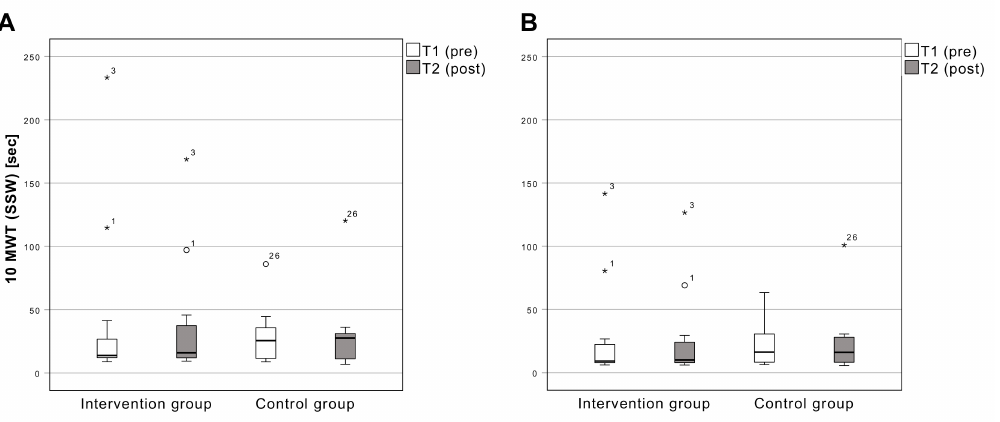
Figure 3. Results of the 10 m walking test with SSW ( A ) and maximum walking speed ( B ). Boxplots: Middle line: median; lower whisker: minimum value; upper whisker: maximum value; circles: Outliers (1.5 times interquartile range); *: extreme outliers (3.0 times interquartile range; numbers: Case numbers); p < 0.05; SSW: Self-Selected Walking Speed; T1: measurement pre-intervention; T2: measurement post-intervention; Confidence interval: 95%; n = 25.